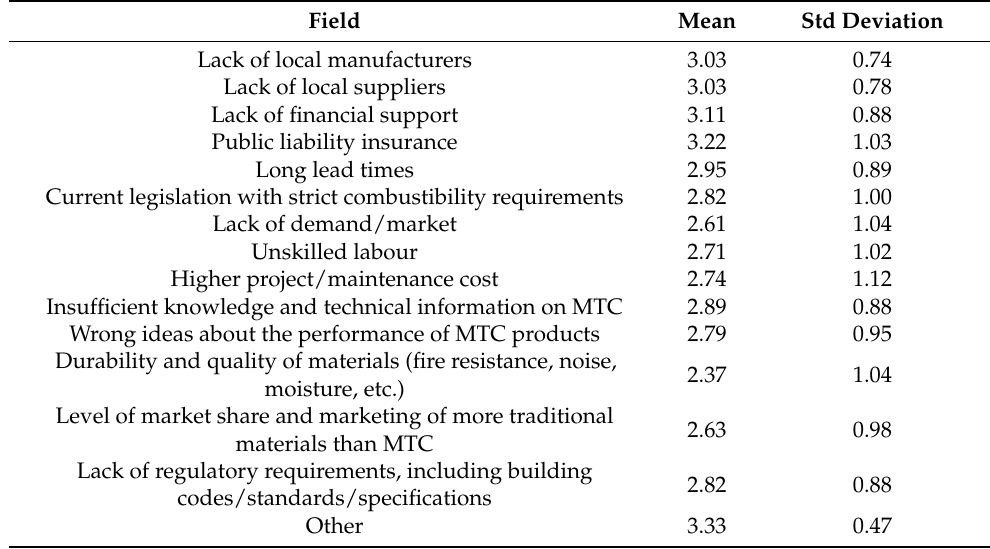
Table 5. Main barriers to widespread acceptance of MTC.